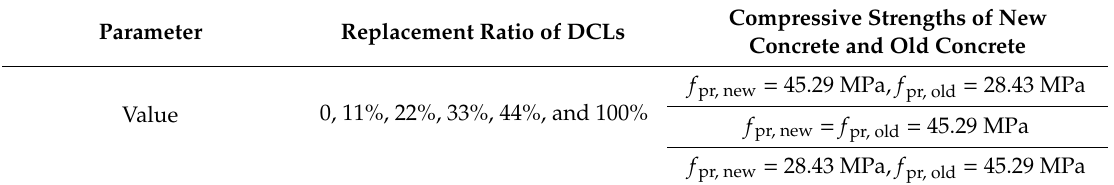
Table 8. Parameter values simulated. DCL—demolished concrete